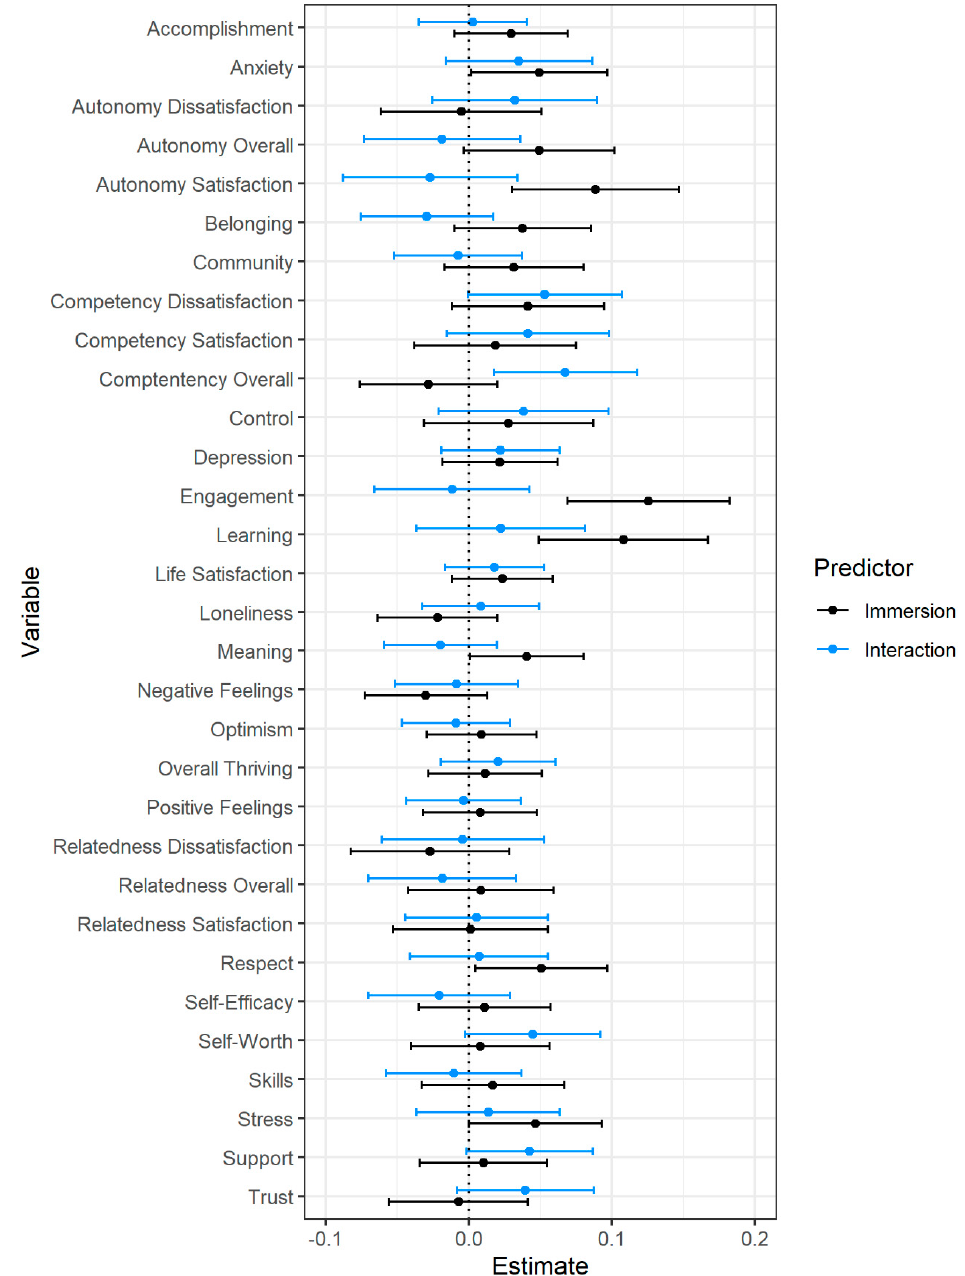
Figure 4. Latent immersion factor and interaction predicting post-intervention well-being. Note. Estimates represent regression weights (controlling for pre-intervention well-being) in pre-intervention standard deviation units. Error bars represent 95% confidence intervals.